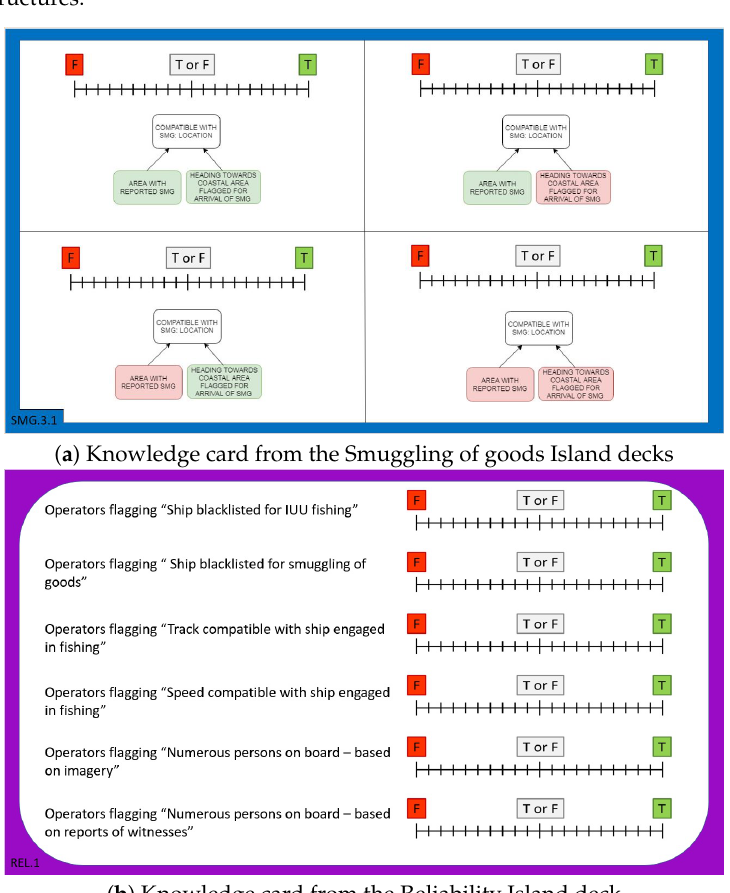
Figure 4. Example of a knowledge